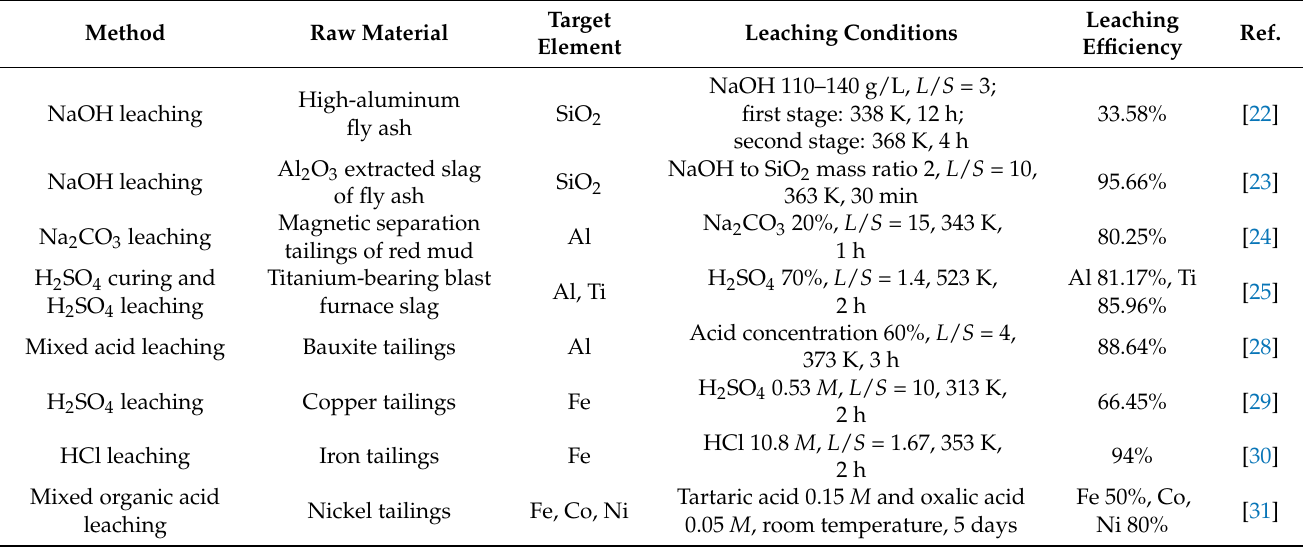
Table 1. Leaching conditions and efficiency of useful components from mine